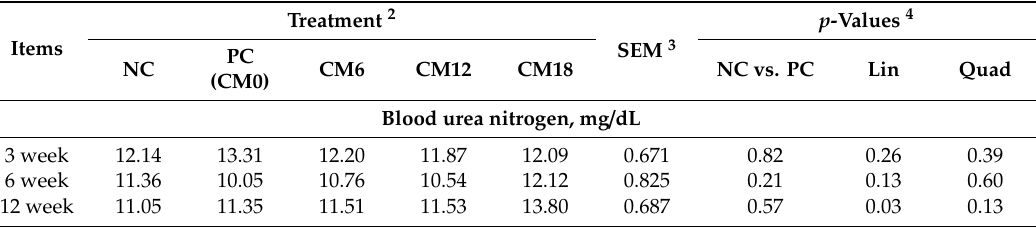
Table 7. E ff ects of copra meal (CM) inclusion level in the diet with β -mannanase on blood urea nitrogen concentrations 1 .